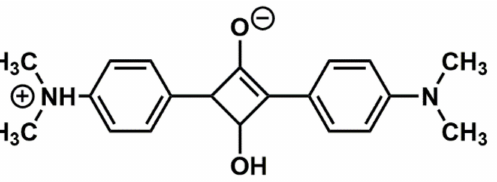
Figure 1. Chemical structure of 2,4-bis[4-(dimethylamin)phenyl]cyclobutane-1,3-diol (DMASQ). Squaric acid (11.5 mg, 0.10 mmol) and N,N -dimethylaniline (29 mg, 0.24 mmol)